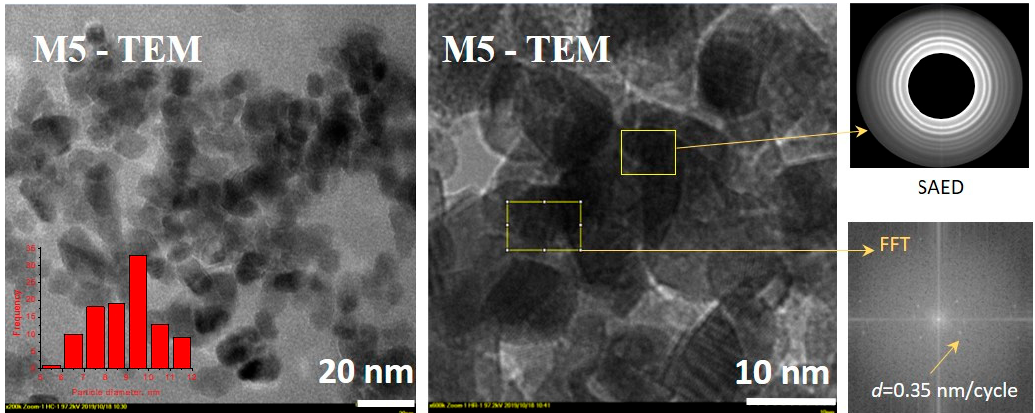
Figure 6. TEM images, particle size distribution plot (in red), selected area electron diffraction (SAED), and FFT for the synthesized TiO 2 nanoparticles—M5 sample.